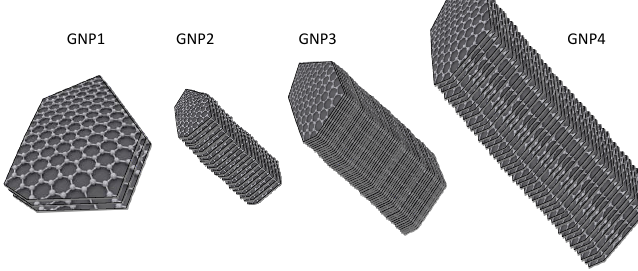
Figure 2. Scheme of graphene nanoplatelets: GNP1, GNP2, GNP3 and GNP4. These schemes are only comparatives. The thickness of nanoplatelets (~nm) is much lower than the lateral dimensions (~ µ m).